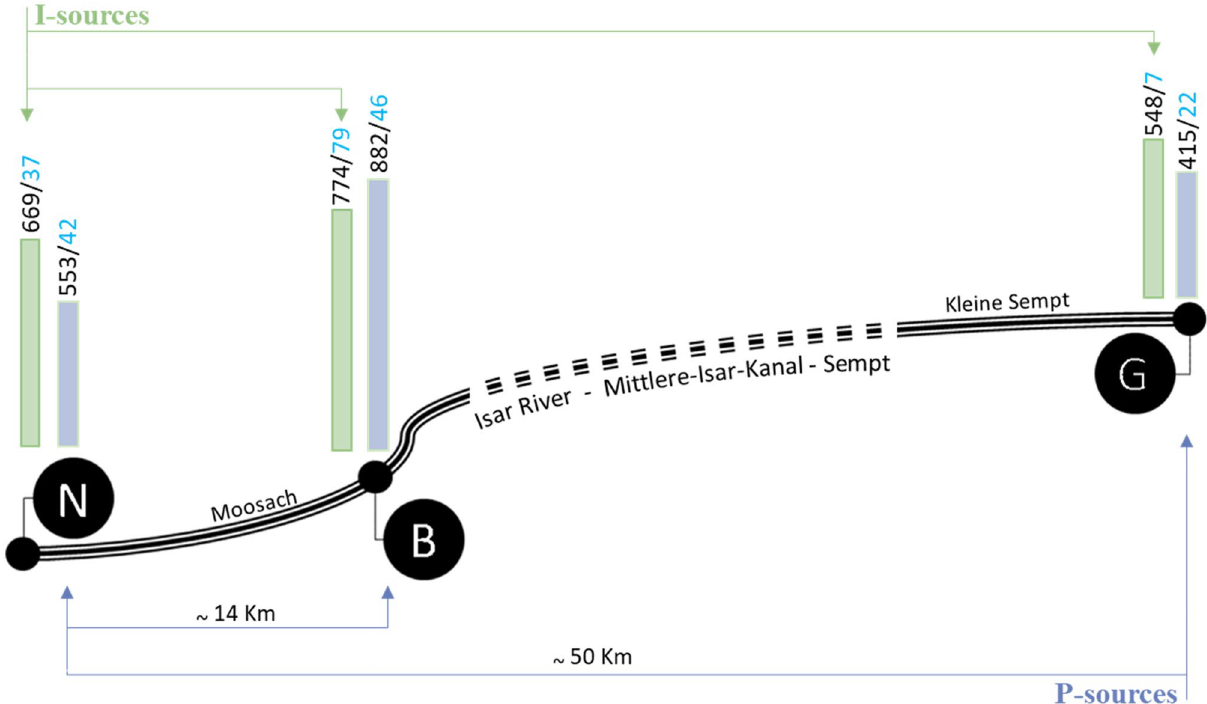
Figure 5. Schematic figure showing the sampling sites and their total number of detected microbial OTUs (bacteria in black/Fungi in blue) in the inflow (I-sources) and ponds water (P-sources)